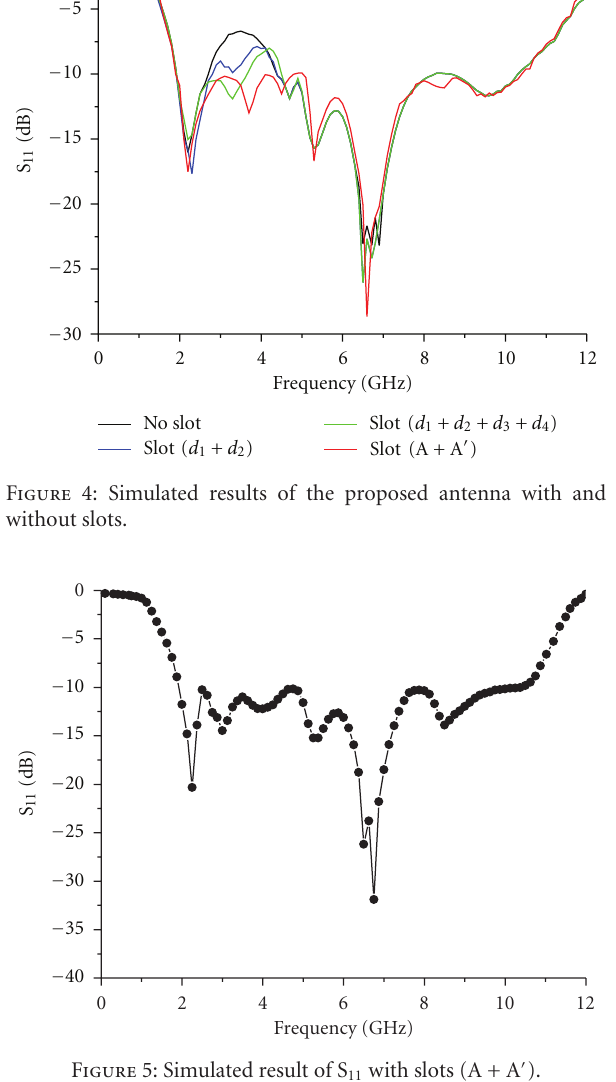
FCC regulated band and also PCS (1.85–1.99 GHz) band.